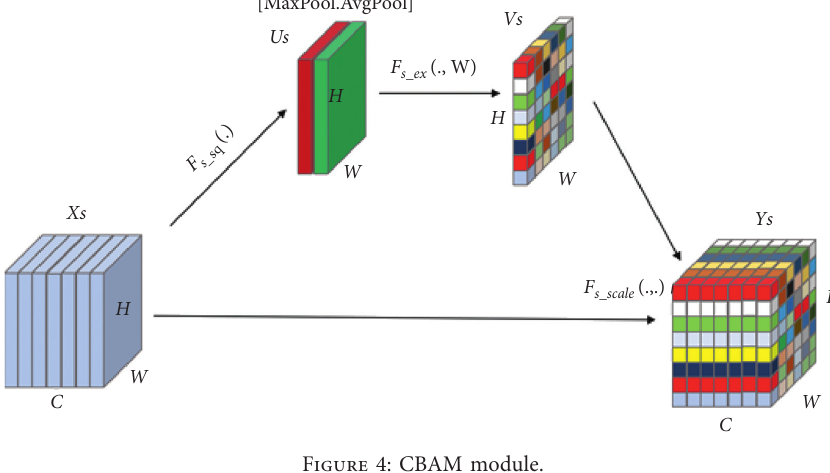
Figure 4: CBAM module.